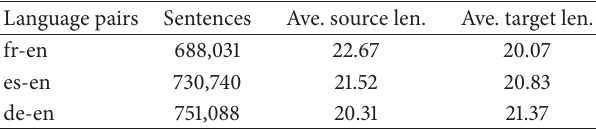
Table 3: Training data statistics: WMT 2006. Table 4: Comparison between theoretical estimation results and other pruning techniques